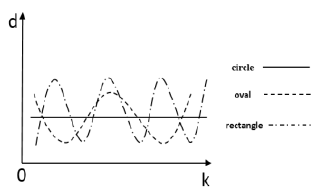
Figure 4. The Centroid Distance Function of different